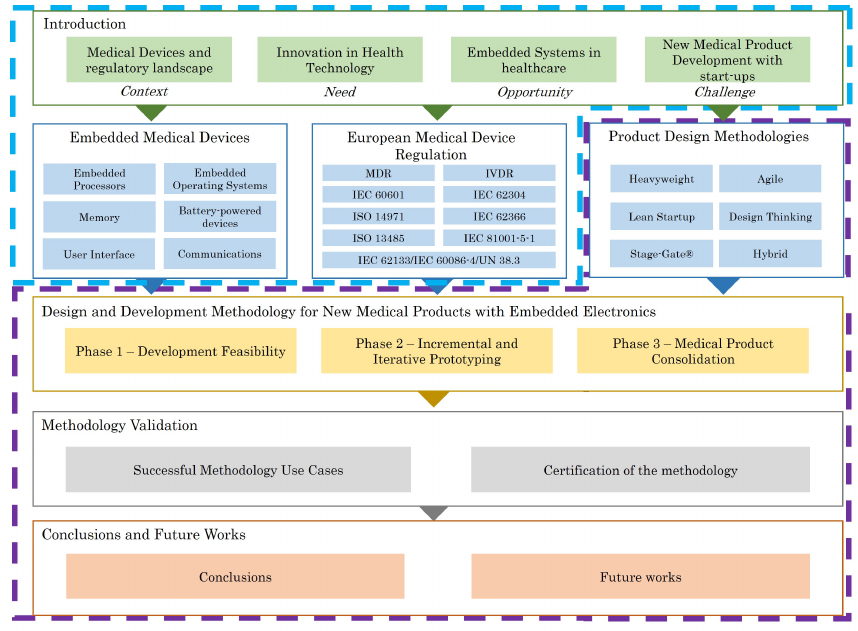
Figure 1. Article context. In blue are aspects addressed in the article [4], and in purple are those covered in this